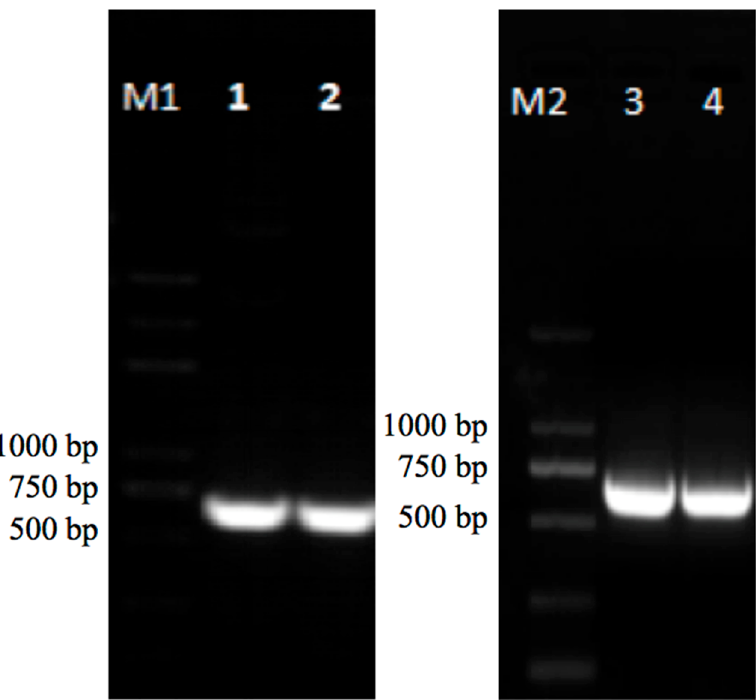
Figure 3. Agarose gel electrophoresis of primer specificity in the amplification of genes. M1 and M2: DL2000 plus marker (TaKaRa); Lane 1–2: Msti-94 (Zhongmu-1); and Msti-94 (WL323), respectively;